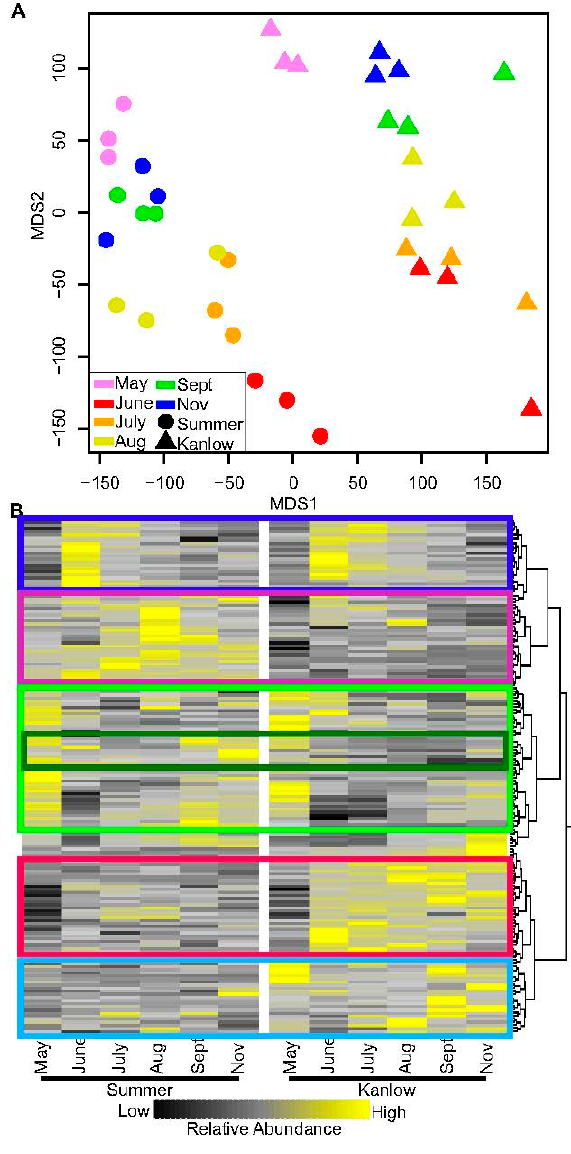
Figure 4. Metabolites present in Kanlow and Summer rhizomes. ( A ) MDS plot of metabolites detected in individual biological replicates obtained from Kanlow ( ▲ ) and Summer ( ● ) at each sampling date. May (purple); June (red); July (orange); August (yellow); September (green); and November (blue). ( B ) Individual metabolite heatmap. Boxes indicate metabolites frequently found in greatest abundances in May (green box); June (dark blue box); August (purple box); September (red box); and November (light blue box). Individual metabolite identity is given in Supplementary Data S1 in the order shown in Figure 2B. Black is low abundance and yellow is high abundance.